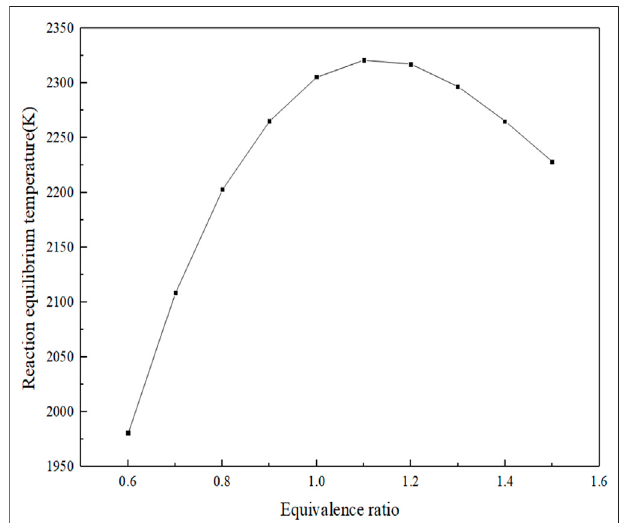
FIGURE 5 | Temperature distribution in oxygen-rich combustion.